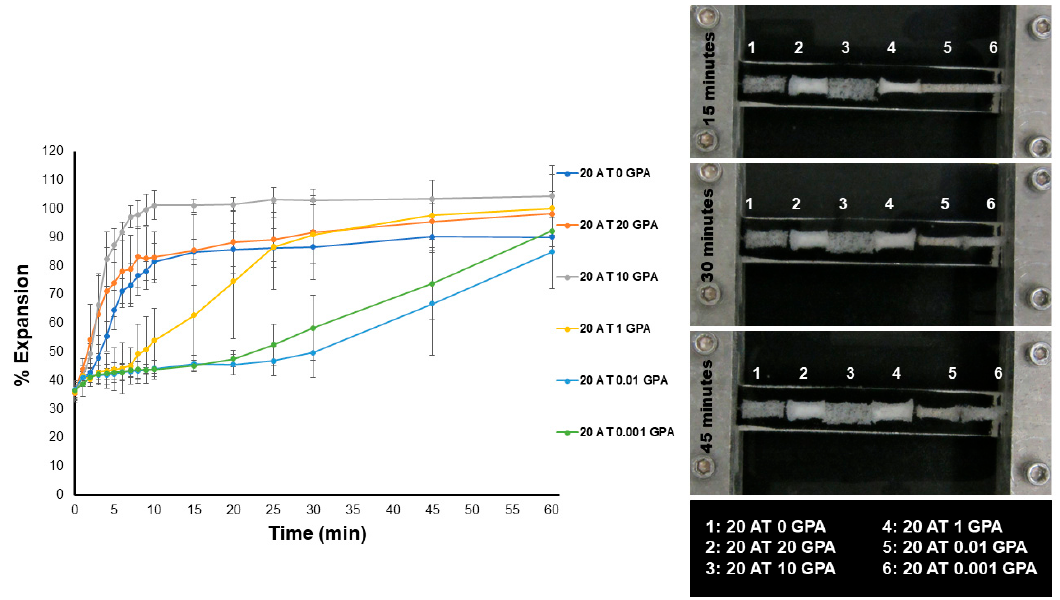
Figure 4. Left — unconstrained expansions of 6 mm diameter foam punches upon exposure to a 37 °C water bath. Images were analyzed every minute for the first 10 min and at 5 min intervals until 30 min, then at 15 min intervals for the remaining time points. Right — images from the water bath at the 15, 30 and 45 min time points to show expansion of foams over time.